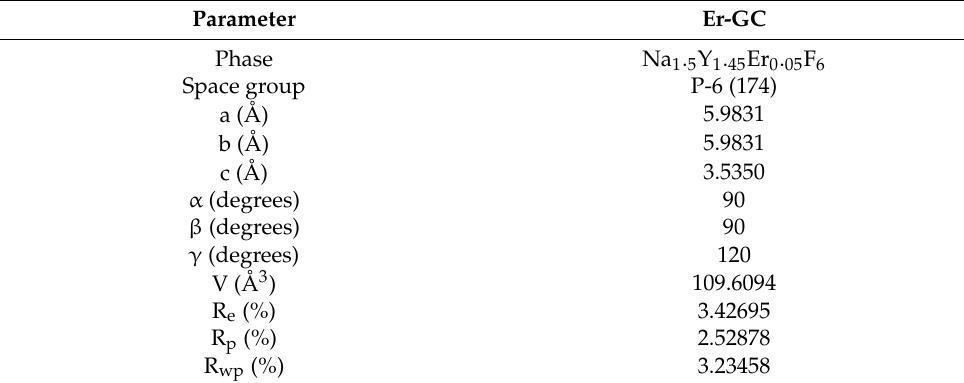
Table 1. Crystal parameters of the hexagonal sodium ytrium fluoride crystals in Er-GC obtained by Rietveld analysis.